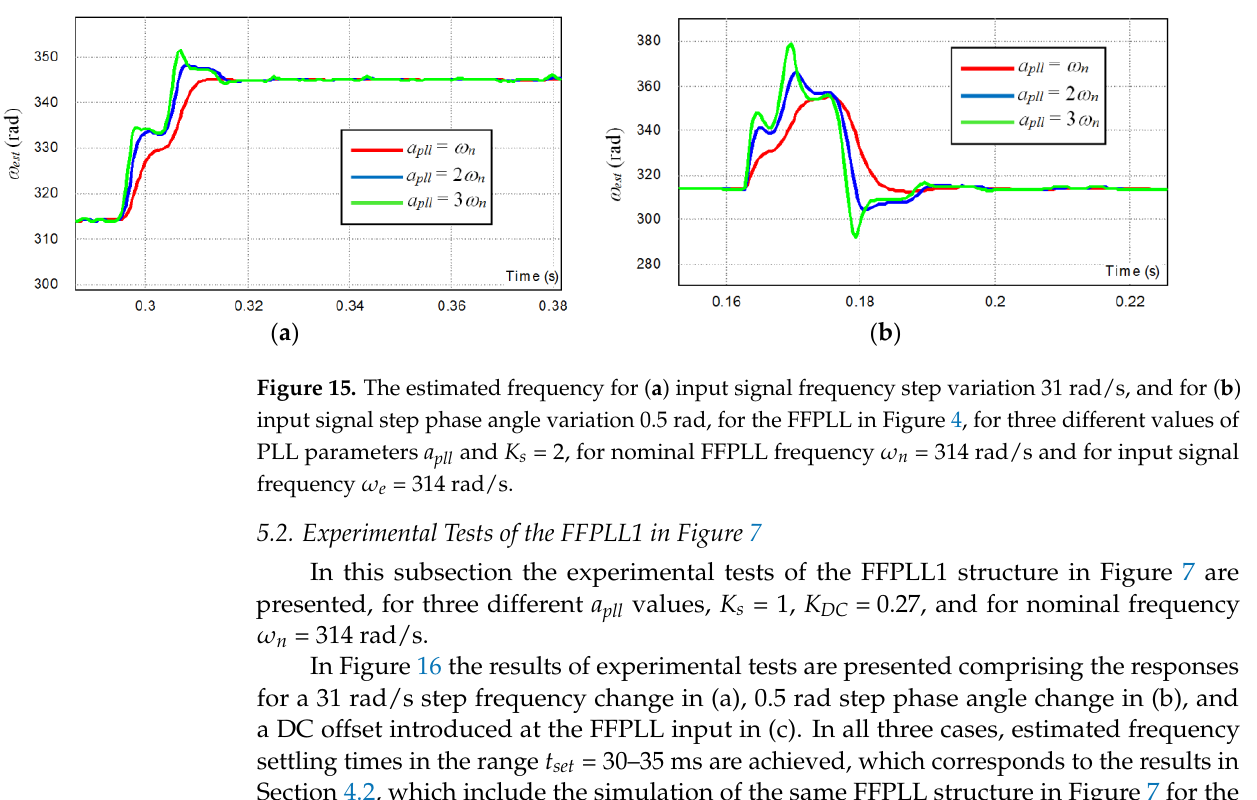
Figure 15. The estimated frequency for ( a ) input signal frequency step variation 31 rad/s, and for ( b ) input signal step phase angle variation 0.5 rad, for the FFPLL in Figure 4, for three different values of PLL parameters a pll and K s = 2, for nominal FFPLL frequency ω n = 314 rad/s and for input signal frequency ω e = 314 rad/s.